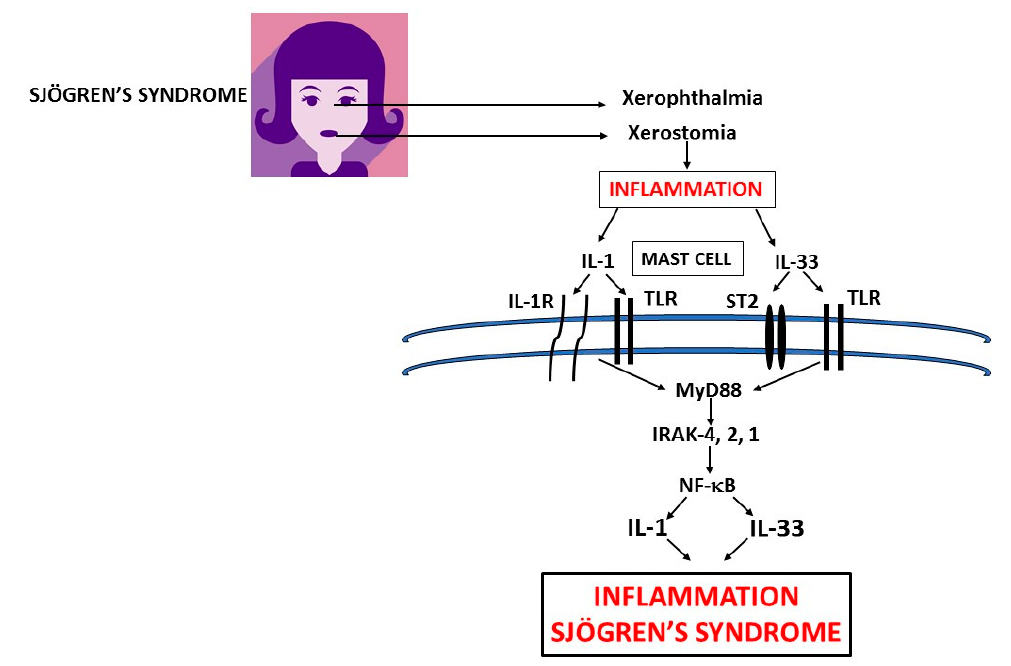
Figure 2. Xerophthalmia and xerostomia glands in primary Sjogren’s syndrome (pSS) inflammation release pro-inflammatory cytokines IL-1 and IL-33 which activate mast cells (MCs) to produce IL-1 family members exacerbating inflammation in pSS. In this figure, we show the biosynthesis of IL-1 and IL-33 which are mediators of systemic inflammation in primary and secondary Sjogren’s syndrome. IL: interleukin; TLR: Toll-like receptor; ST: soluble transmembrane; MyD: Myeloid di ff erentiation primary response; IRAK: IL-1 receptor-associated kinase; NF- κ B: nuclear factor kappa-light-chain-enhancer of activated B